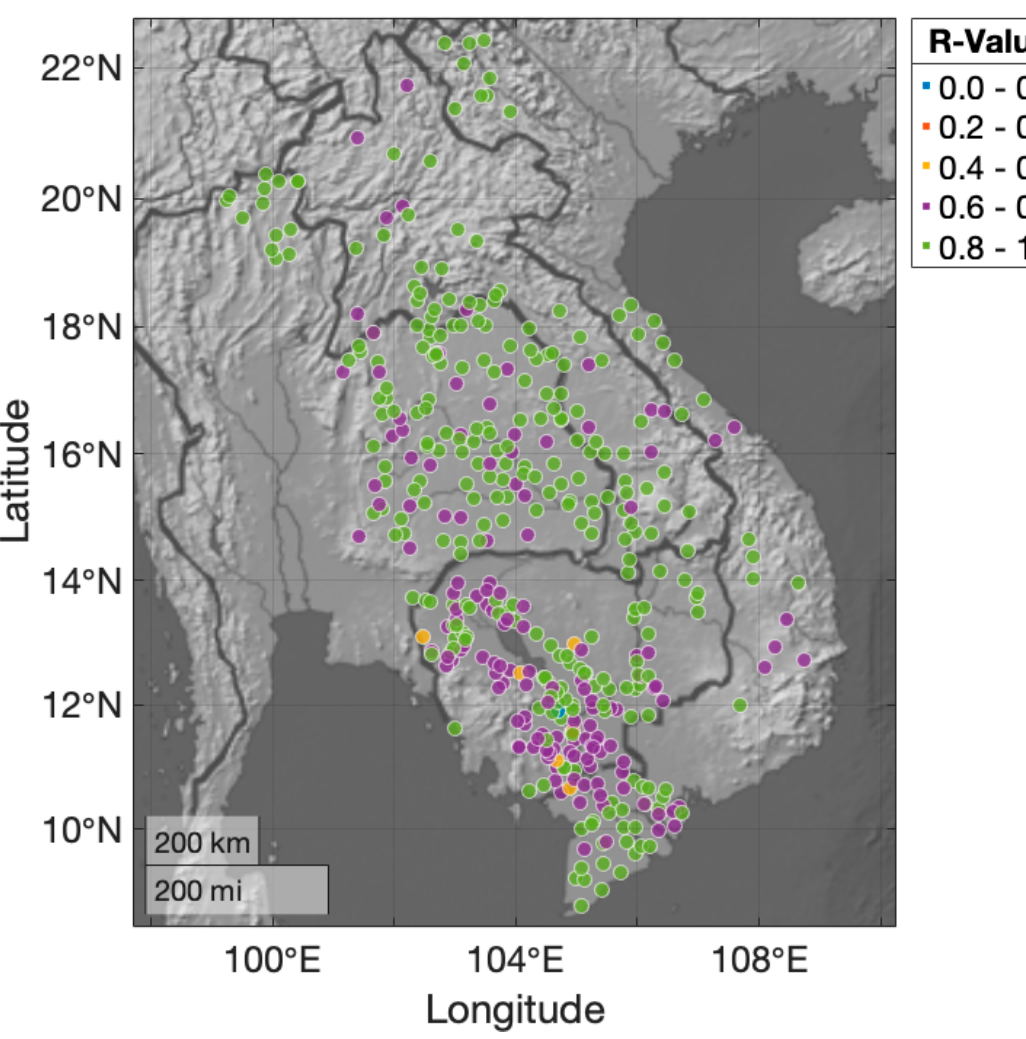
Figure 6. Spatial correlation results of mean r-value for each rain gauge stations against CHIRPS precipitation estimates for monthly rainfall.